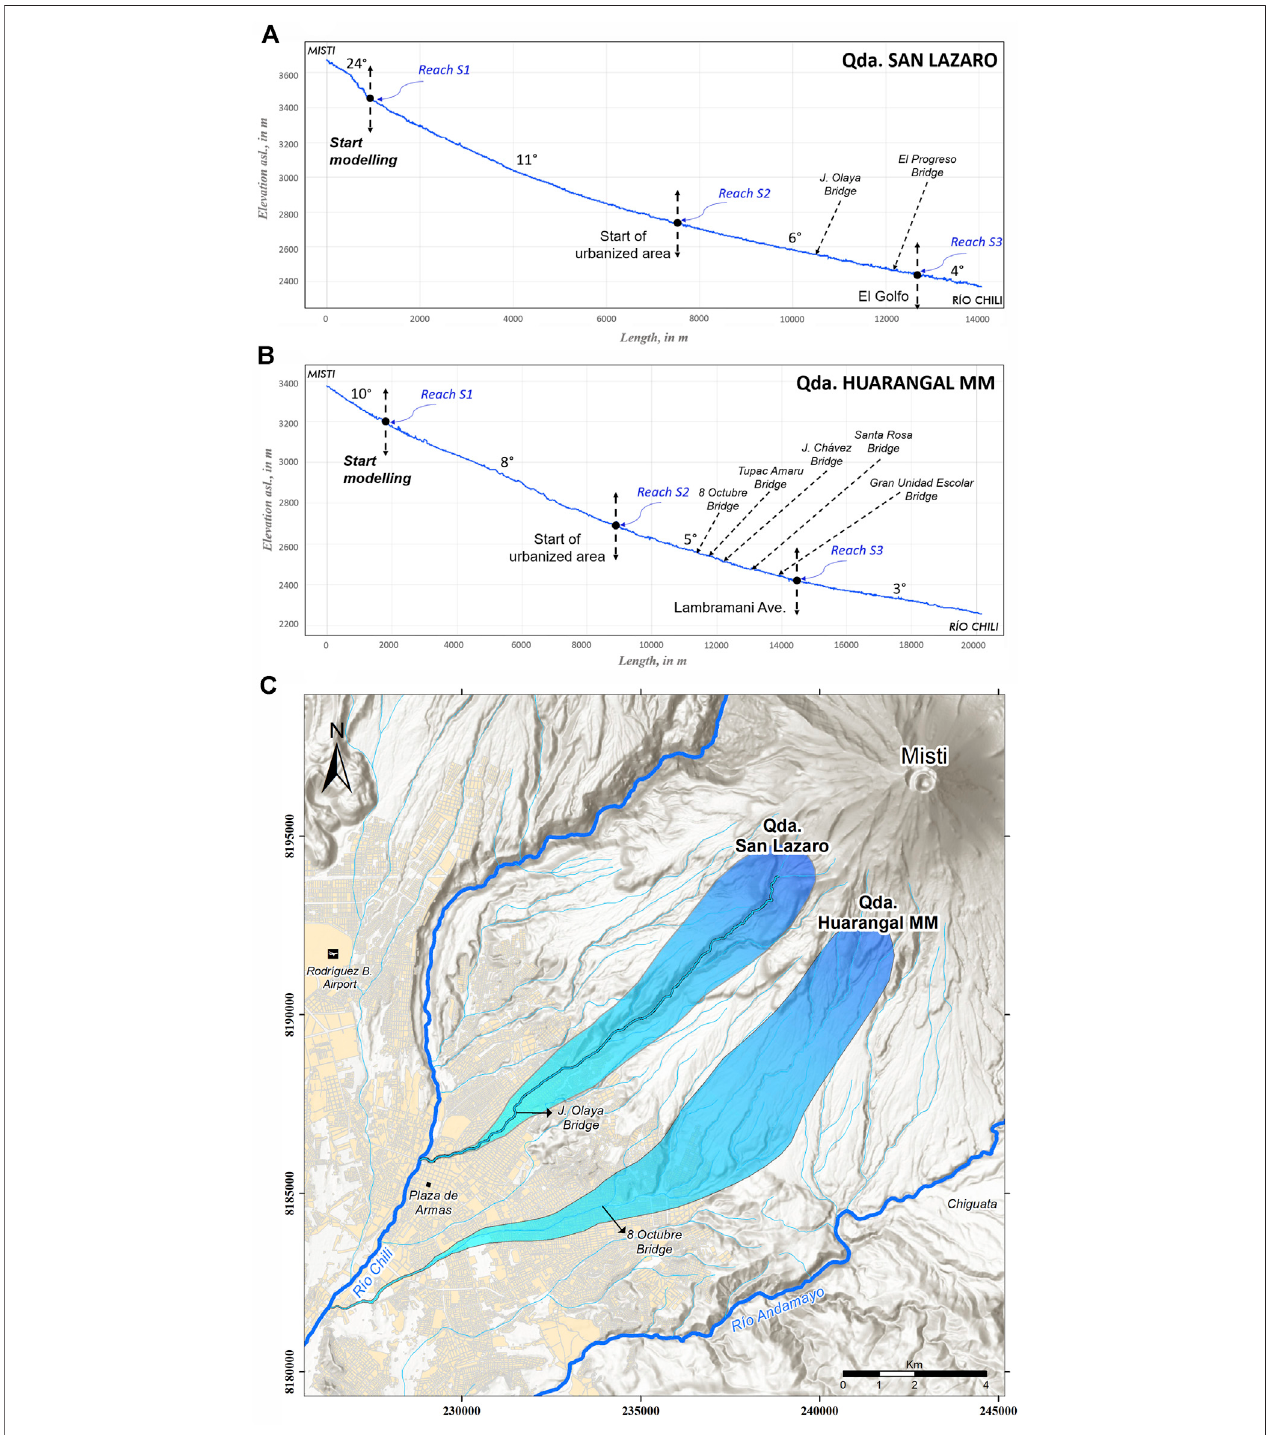
FIGURE 2 | Catchment and longitudinal pro fi les of the Quebradas (ravines): (A) Qda. San Lazaro (SL) and (B) Qda. Huarangal-MM. (C) Outline and extent of the drainage basins of the two ravines under study. Bridge locations and names are indicated along both ravine pro fi les. See Table 1 for morphometric parameters of both